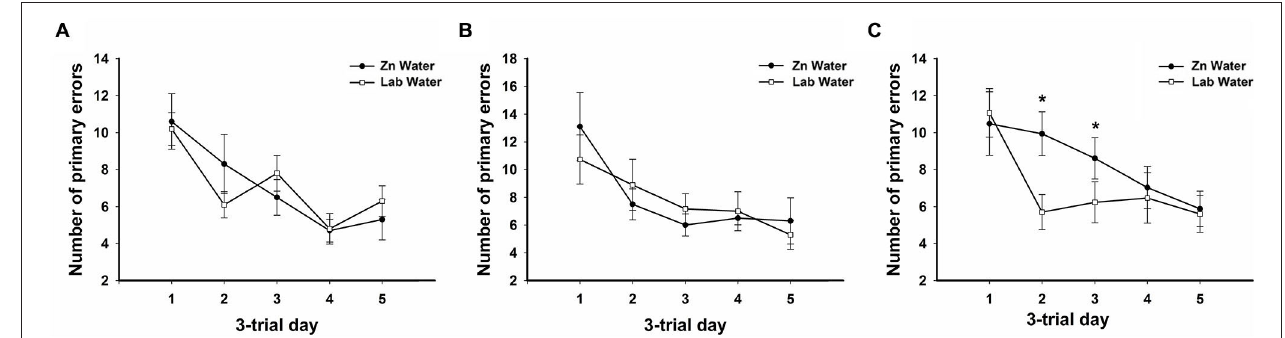
FIGURE 2 | Average primary errors for all genotypes. There were no significant differences between Zn and Lab water (A) WT and (B) CRND8 mice. (C) Within the CRND8/E4 mice, however, those on Zn water had significantly more primary errors than the lab water group on days 2 and 3 ( p < 0.05). Points are mean ± SEM. * denotes p < 0.05.